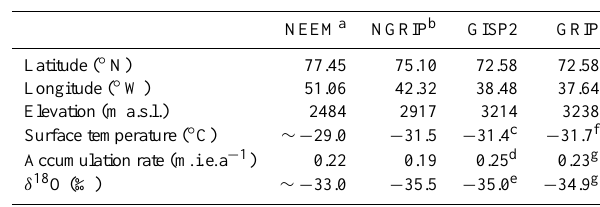
Table 1. Present-day characteristics of NEEM, NGRIP, GISP2 and GRIP drilling sites (m.i.e., meters ice